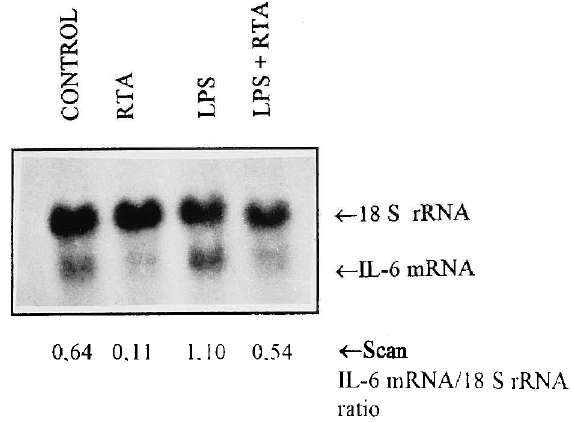
FIG. 3. Effect of RTA (10 m M) and/or LPS (500ng/ml) on IL-6 mRNA abundance in PMA-primed U937 cells after 18h incubation (cf. Fig. 2). For comparison, the hybridization pattern of 18 S rRNA is shown. The ratios of densitometric scans of IL-6 mRNA to18 S rRNA are reported.